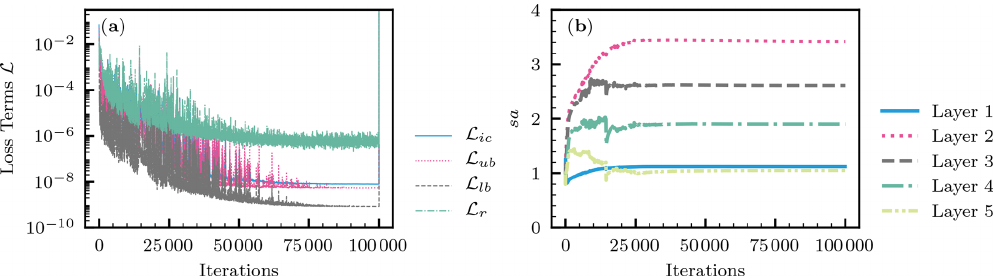
Figure 4. Homogeneous soil. (a) The evolution of the loss terms for the initial condition L ic , the upper-boundary condition L ub , the lower- boundary condition L lb , and the residual L r during the Adam (100000 iterations) and the following L-BFGS-B training. ( b ) The evolution of the adaptive parameter sa for layer-wise locally adaptive activation functions (Eq. 9) for each hidden layer (Layer 1 is next to the input layer).